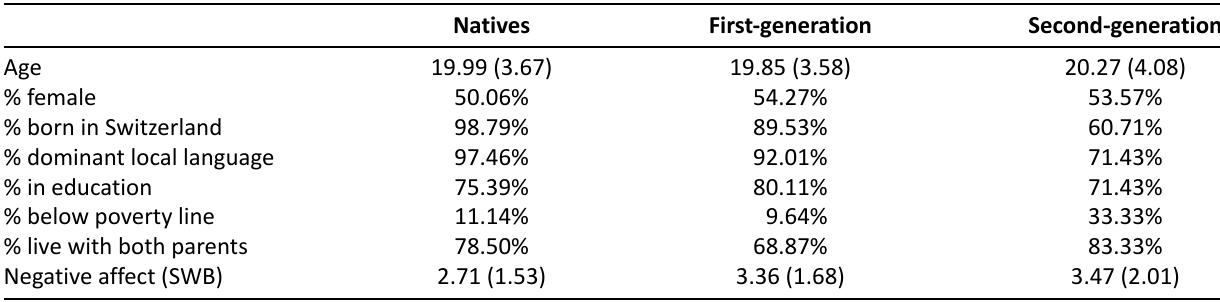
Table 1. Descriptive statistics for the three subsamples (means and standard deviations are provided for continuous